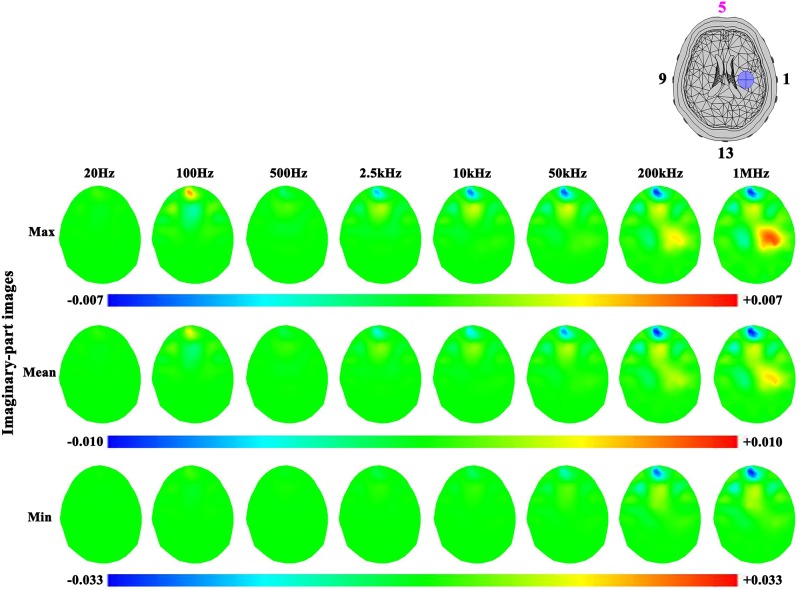
Imaginary-part images of the hemorrhagic stroke lesion and the effects of three levels of contact impedance.